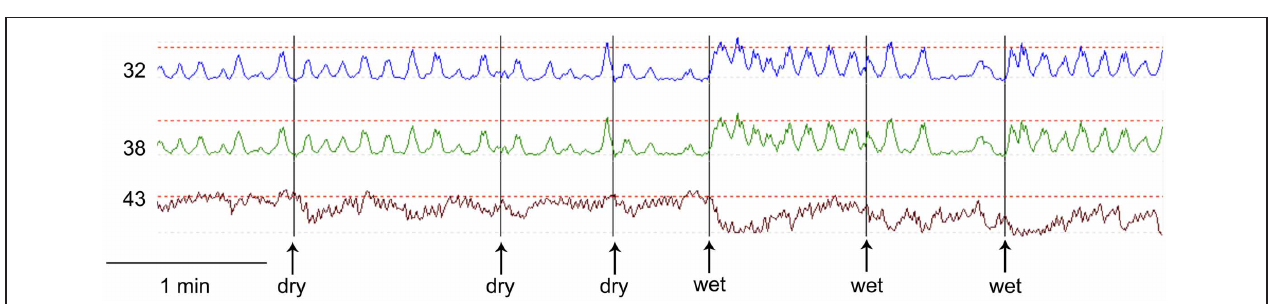
FIGURE 2 | Comparison of dry swallows (dry) and wet swallows (wet). The first dry swallow has no effect on amplitude or frequency of the rhythmic contractions. Subsequent dry swallows tend to decrease the amplitude of the